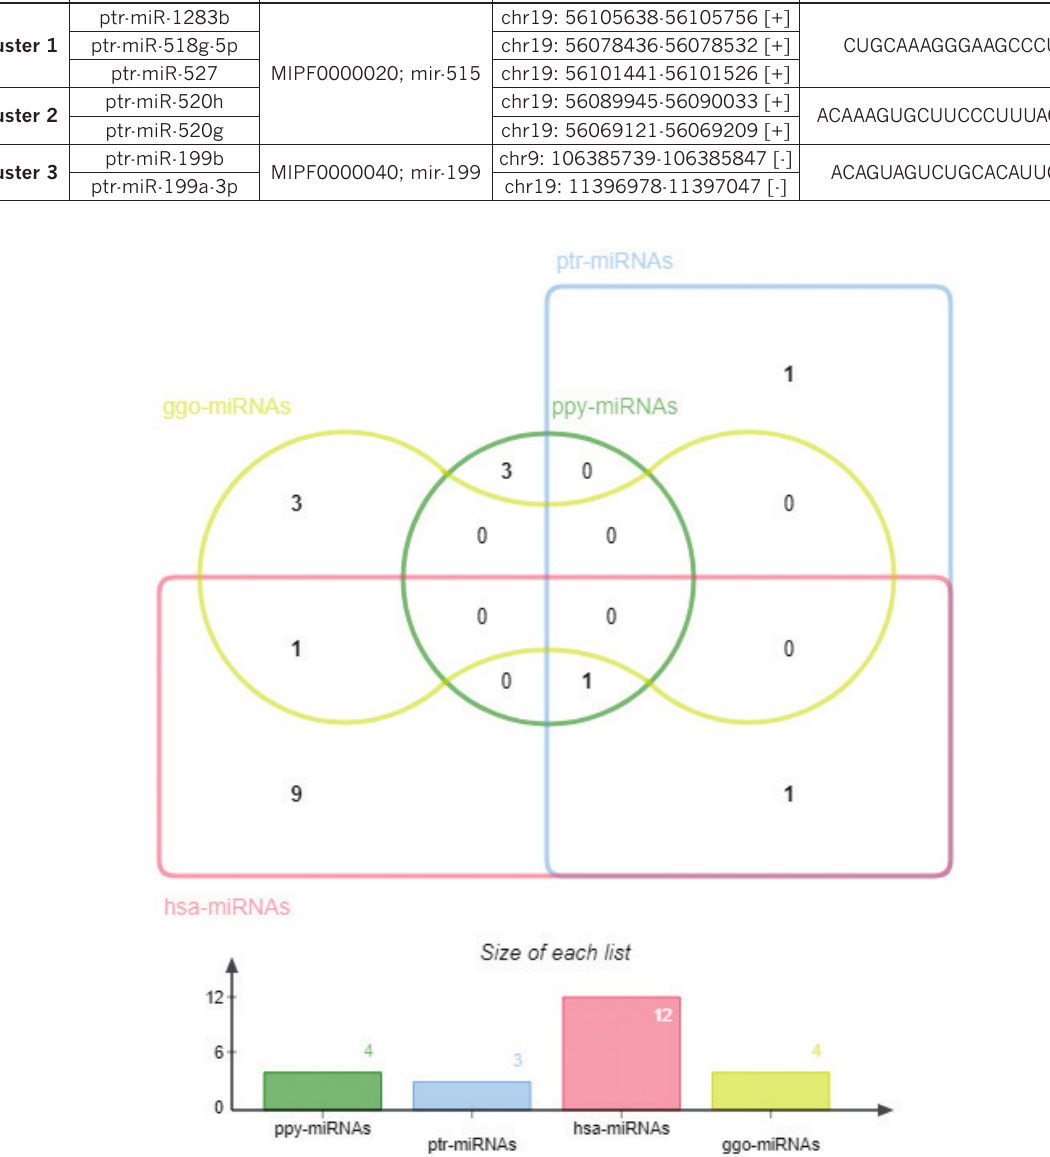
Figure 6. Venn diagram representing number of overlapping miRNA in Homo sapiens , Gorilla gorilla , Pongo pygmaeus and Pan